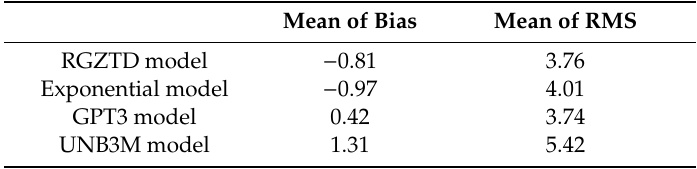
Table 3. Mean bias and RMS of RGZTD model, Exponential model, GPT3 model and UNB3M model with respect to CMONOC ZTD data in 2016–2017